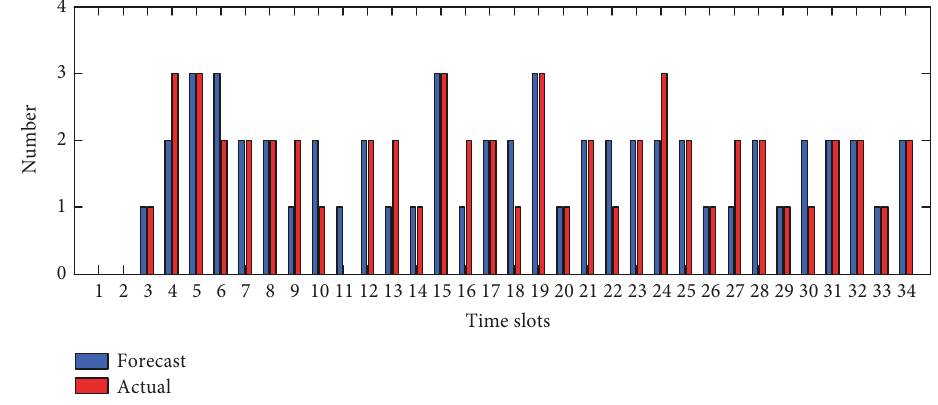
Figure 5: Forecast and actual values of battery swapping demand.